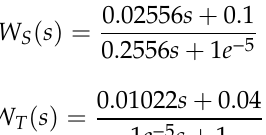
Figure 10. Step responses with a modified scheduled PI controller.